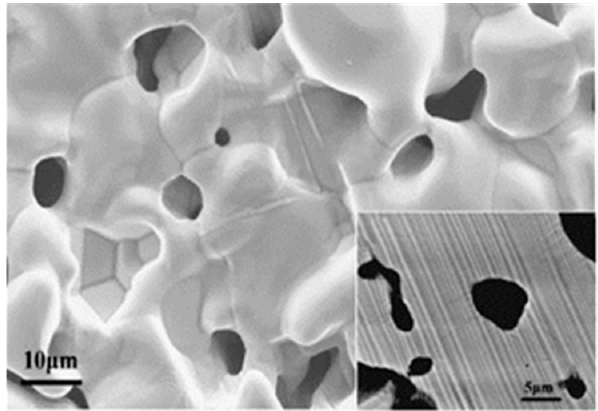
Figure 4. SEM image of the Ti–48Al–6Nb alloy coating surface (inset presents the cross-section of the coating skeletons). Reprinted from “Innovative fabrication of Ti–48Al–6Nb porous coating by cold gas spraying and reactive sintering” [94], © 2012, with permission from Elsevier.